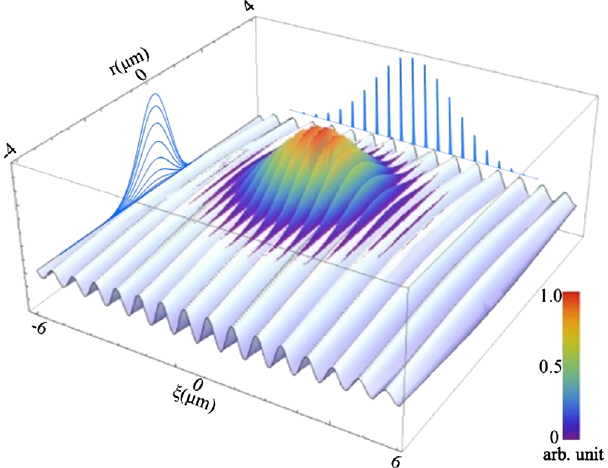
FIG. 2. Visualization of laser-triggered ionization photoelec- tron yield. The color-coded elevation is the normalized ionization probability rate distribution inside the laser pulse, while the laser pulse profile is shown at the base. The probability distribution is also projected to show longitudinal and axial